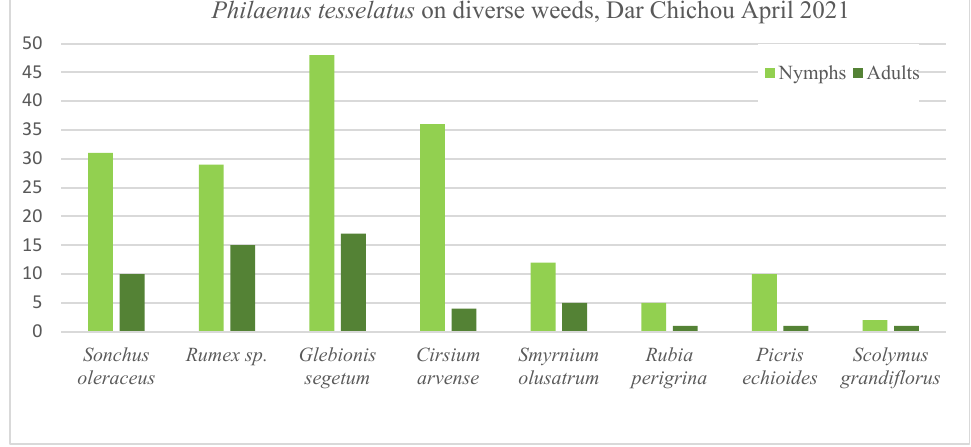
Figure 5. Spittlebug nymphs and adults counted on foliar sampling weeds at Dar Chichou, Tunisia.